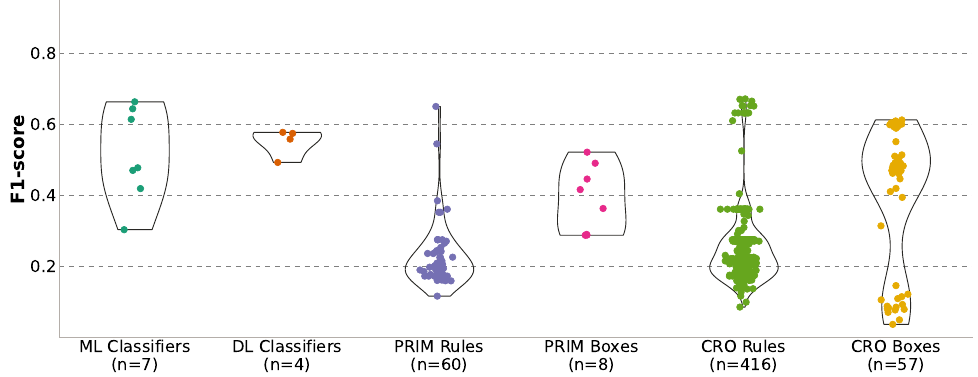
Figure 13. Distribution of test error for the different classification techniques considered using a time prediction horizon of +3